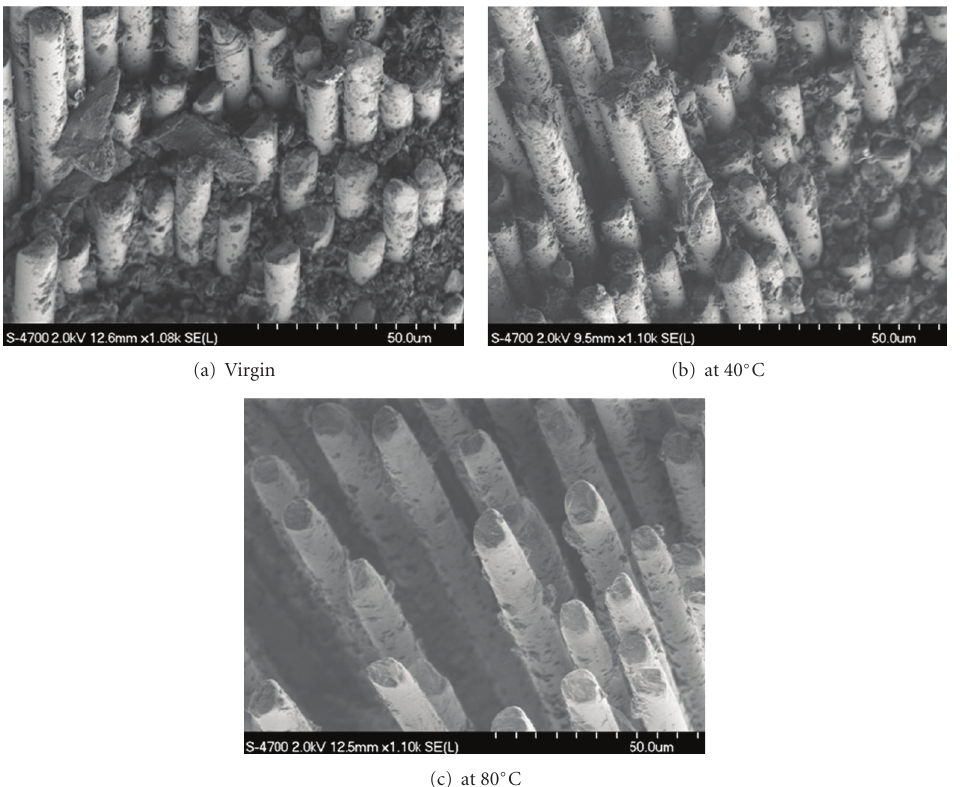
Figure 8: Comparison of the failure surfaces of unaged (virgin) perforated GFRP specimens and aged specimens at various temperatures (at 60% humidity).